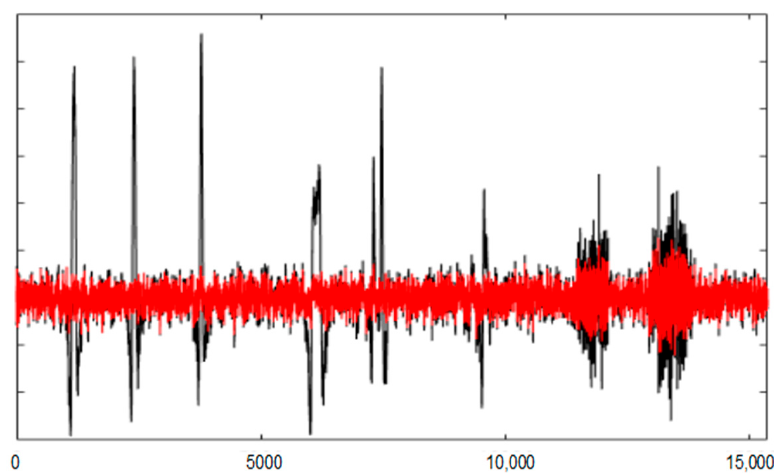
Figure 22. The AF8 channel of SEEG with (in black) and without artefacts (in red) after using wICA. The X axis shows the samples.